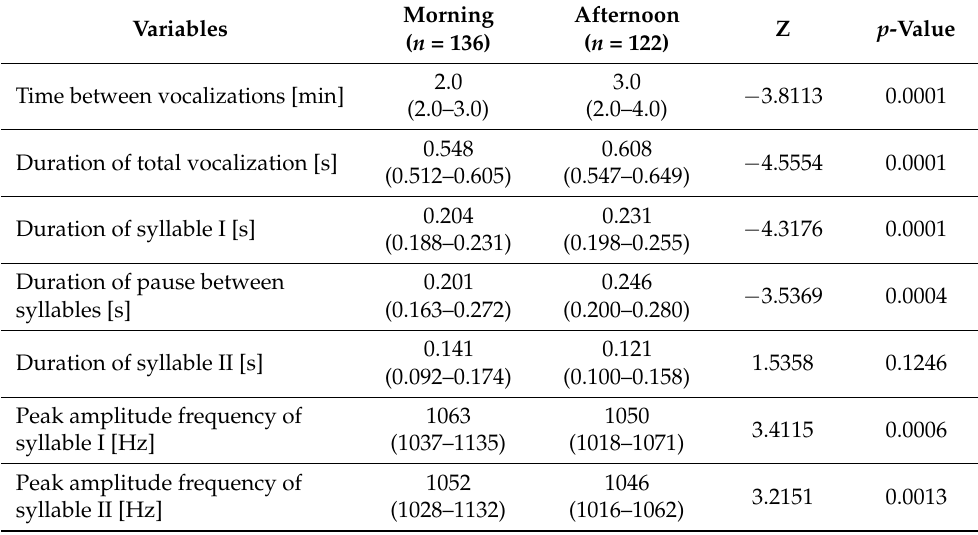
Table 3. The distribution of variables according to the time of